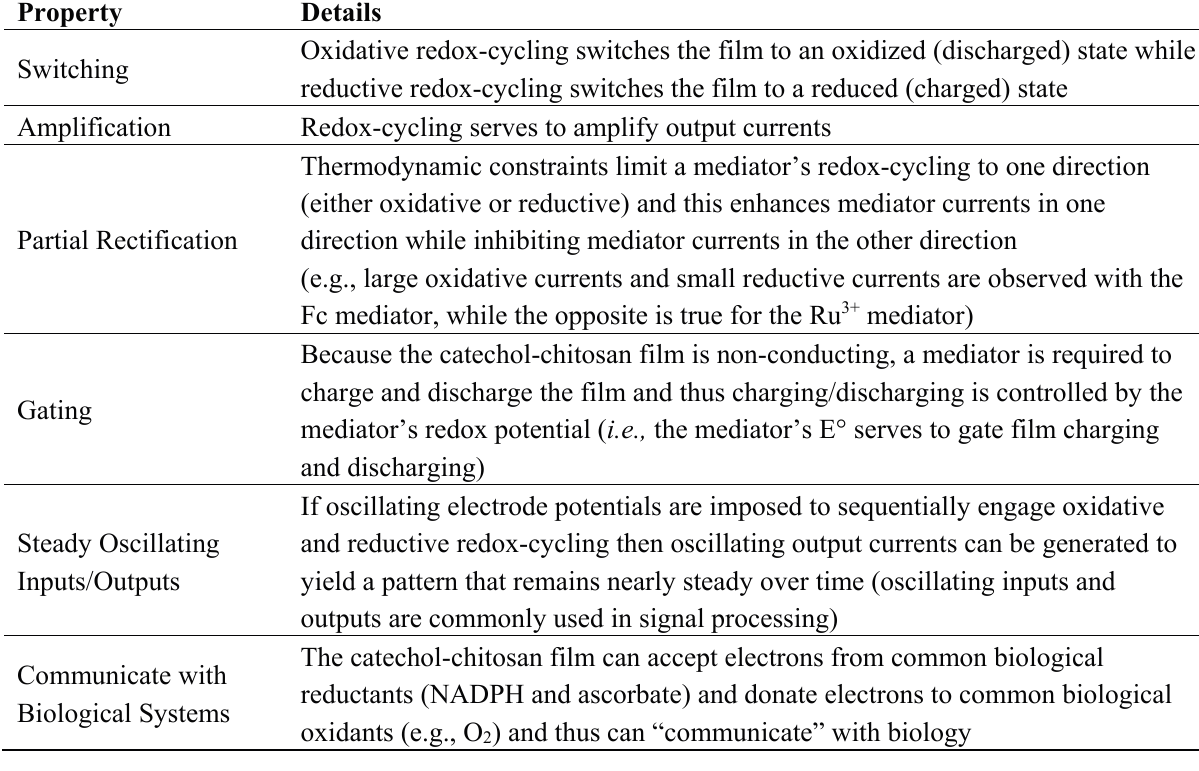
Table 5. Molecular electronic properties of the catechol-chitosan redox-capacitor